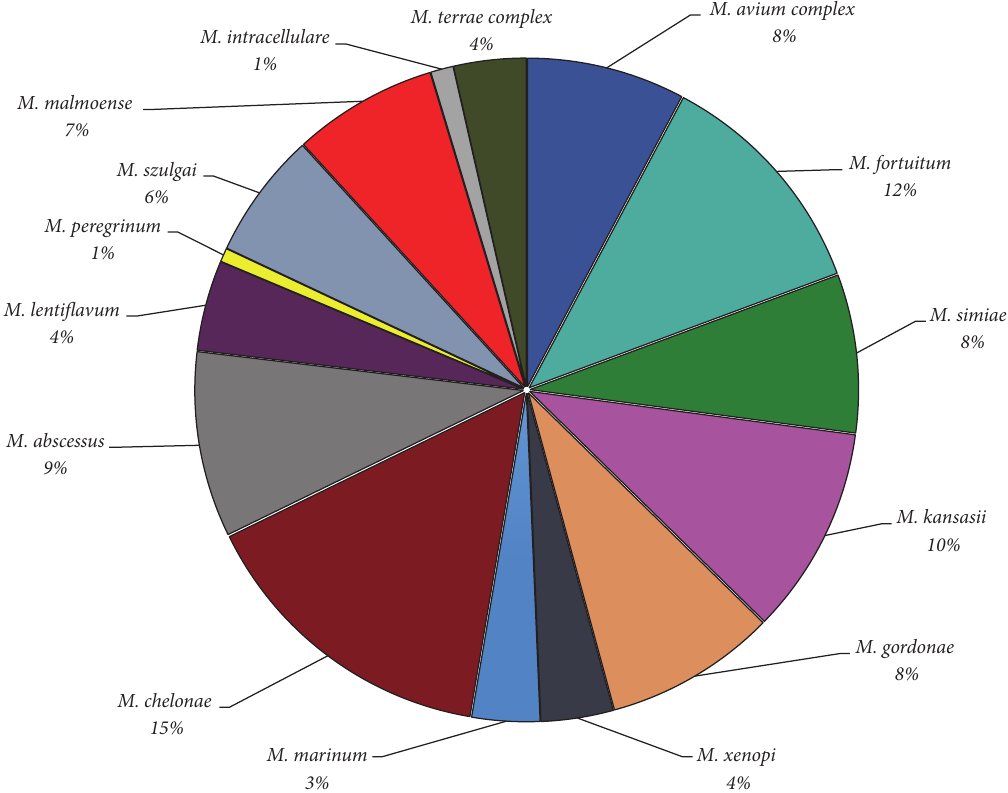
Figure 3: Environmental isolates reported from Saudi Arabia, Iraq, and Turkey. Illustrating the environmental diversity of NTM in Saudi Arabia, Iraq, and Turkey. Species’ names and their relevant environmental percentages are also illustrated. References [44, 52,